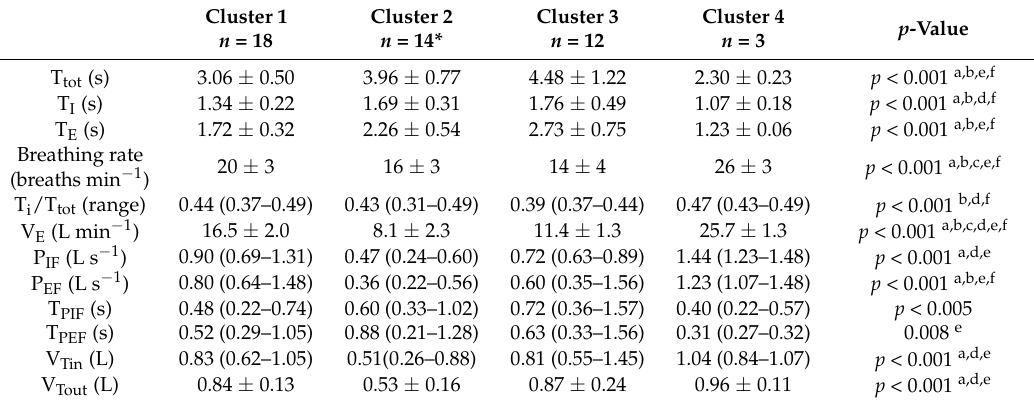
Figure 4. Percentage distribution of participants (three idiopathic pulmonary fibrosis (IPF) groups and controls) within clusters. Controls (white), n = 18; IPF Stage 1 (black), n = 10; IPF Stage 2 (light grey), n = 12; IPF Stage 3 (grey), n = 9. Table 1. Comparisons between breathing parameters in cluster